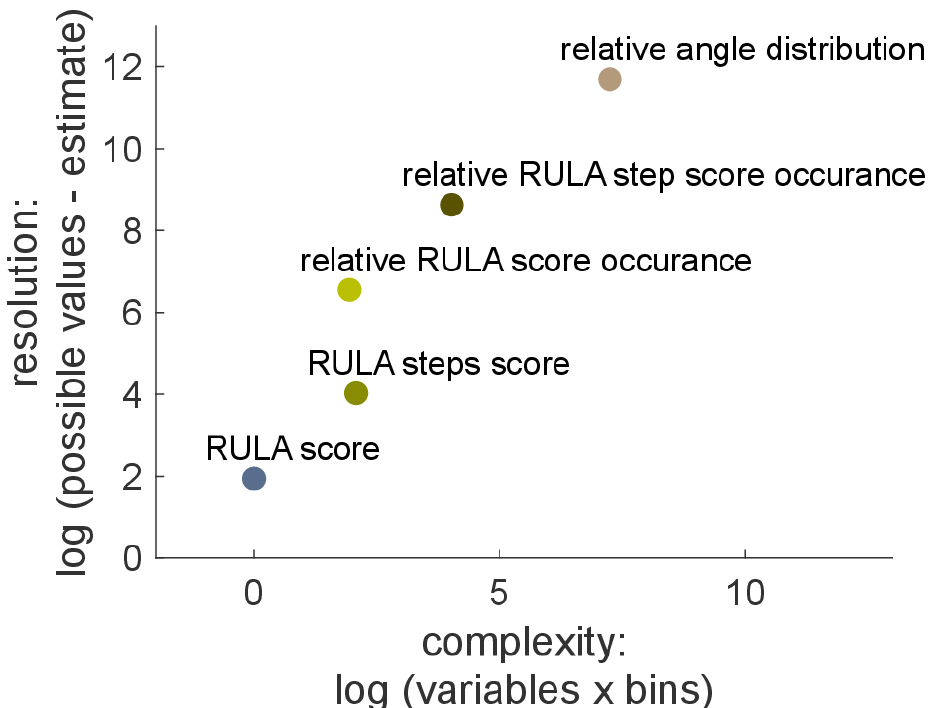
Figure 4. Complexity versus resolution . The complexity was based on the number of variables used in the individual steps. The resolution is based on the number of scores or on the number angles, where 1° bins were